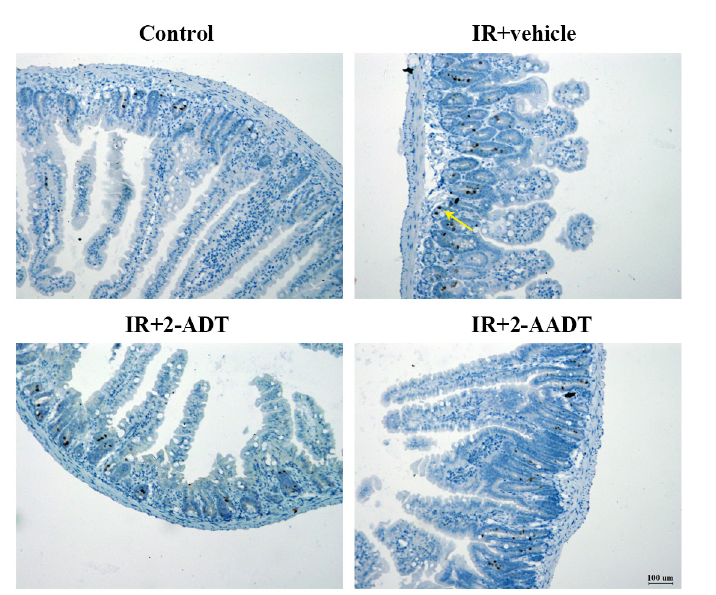
Figure 7. Representative immunohistochemical images of nitrotyrosine in different groups of small intestine on day 3 after exposure to 13 Gy of abdominal irradiation. 2-ADT and 2-AADT were administered i.p. 30 min before irradiation. the yellow arrow indicates nitrotyrosine staining. Scale bar, 100 µ